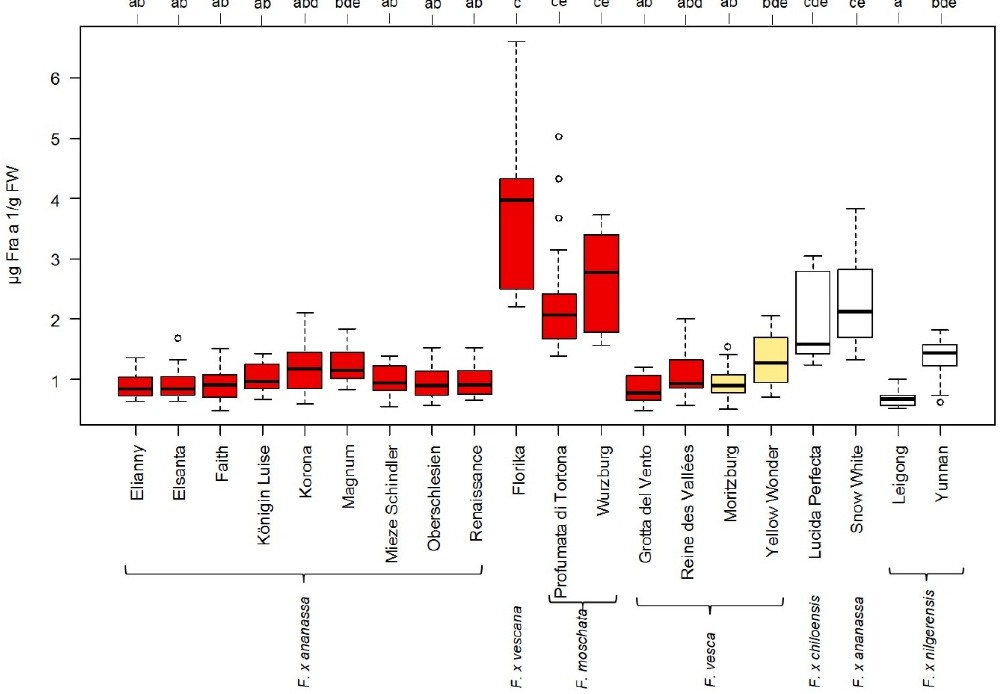
Figure 2. Fra a 1 content in fruits of different strawberry genotypes. Allergen content in µg Fra a 1/g FW determined with indirect competitive ELISA. The color of the box plots corresponds to the color of the ripe strawberry fruits. Comparisons of median values were performed by the Dunn’s Test. Significant differences for each cultivar were calculated at a significance level of 5% ( p value ≤ 0.05) indicated with letters a–d.